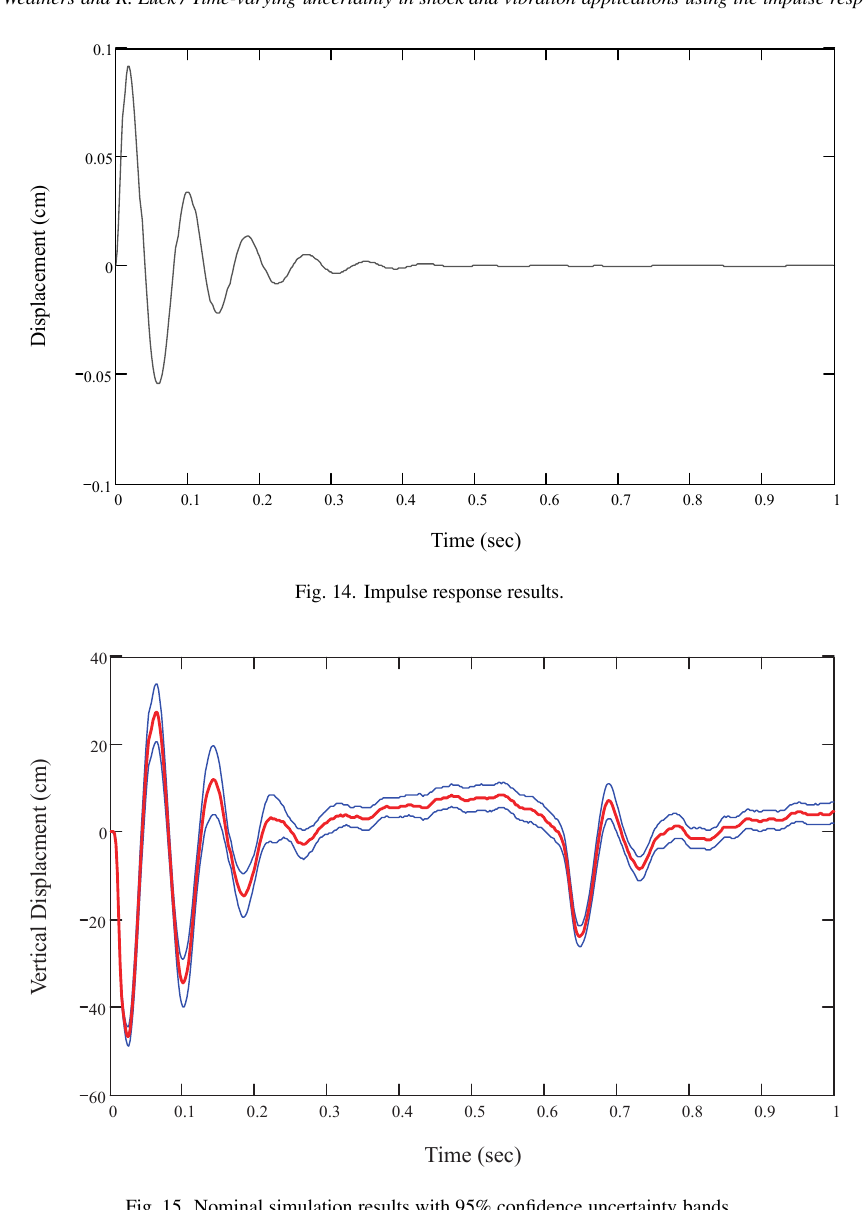
Fig. 15. Nominal simulation results with 95% con fi dence uncertainty